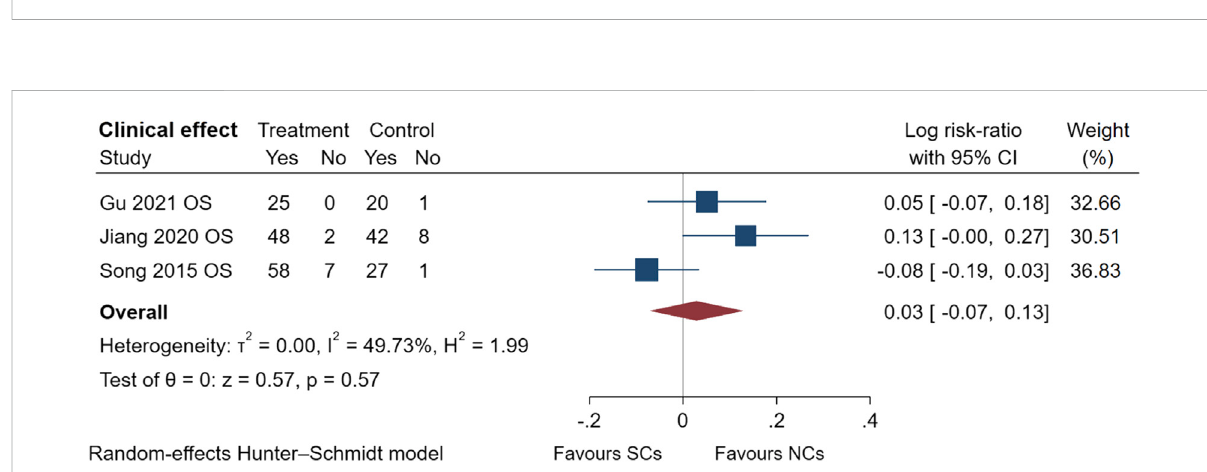
Clinical effect of SCs and NCs in observational studies and randomized controlled